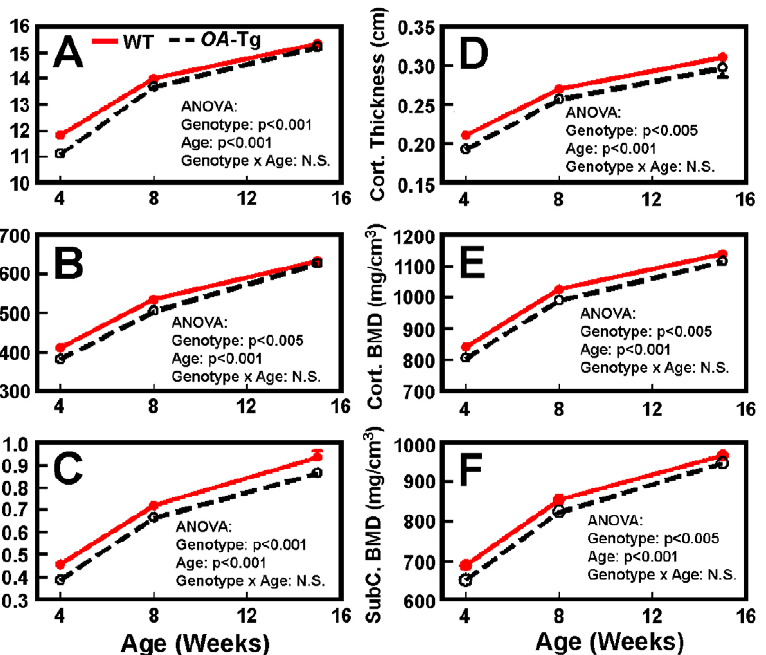
Figure 4. Age effects on relative differences in pQCT bone parameters between OA -Tg mice and corresponding WT littermates. The femur length (A), total BMD (B), cortical bone area (C), cortical thickness (D), cortical BMD (E), and subcortical BMD (F) at midshaft of femur of female OA -Tg mice and corresponding WT littermates of 4, 8, and 15.3 weeks of age were each plotted against corresponding age of the animals. Statistical significance of age, genotype, and age 6 genotype interaction was determined by two-factor